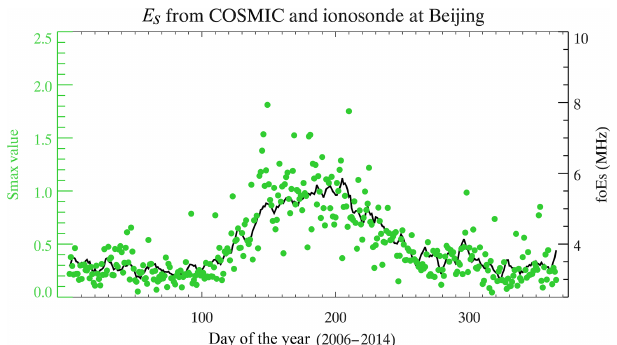
Figure 2. The entire distribution of the daily average E s intensity retrieved from COSMIC within ± 2 . 5 ◦ latitude and longitude of one ionosonde station and ionosonde data ( f o E s ) in Beijing from 2006 to